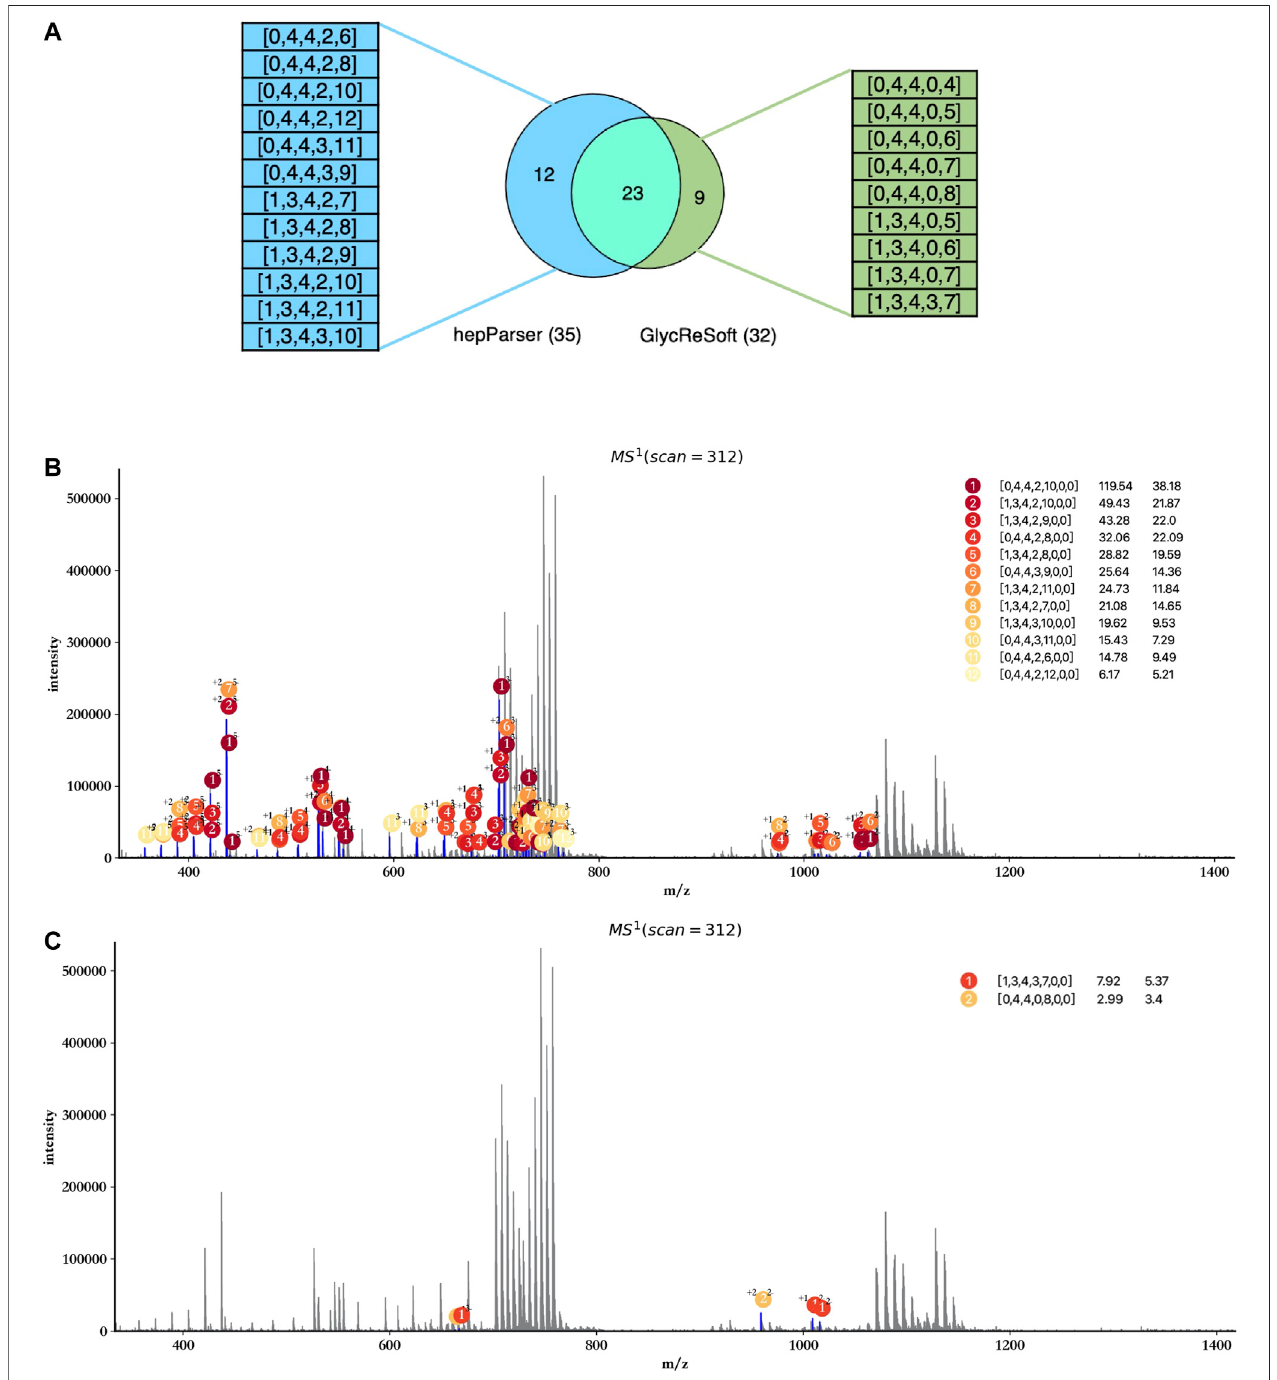
FIGURE8| ComparisonbetweenhepParserandGlycReSoftresultsoftriplicateHSsamples. (A) RelationshipofhepParserandGlycReSoftresults.The12distinct components ofhepParserareontheleft(in blue),while theninedistinctcomponents ofGlycReSoftareontheright (ingreen). (B) Annotationresultsusing the12distinct components of hepParser. (C) Annotation results using the nine distinct components of GlycReSoft (other seven components which matched no peak are not shown).